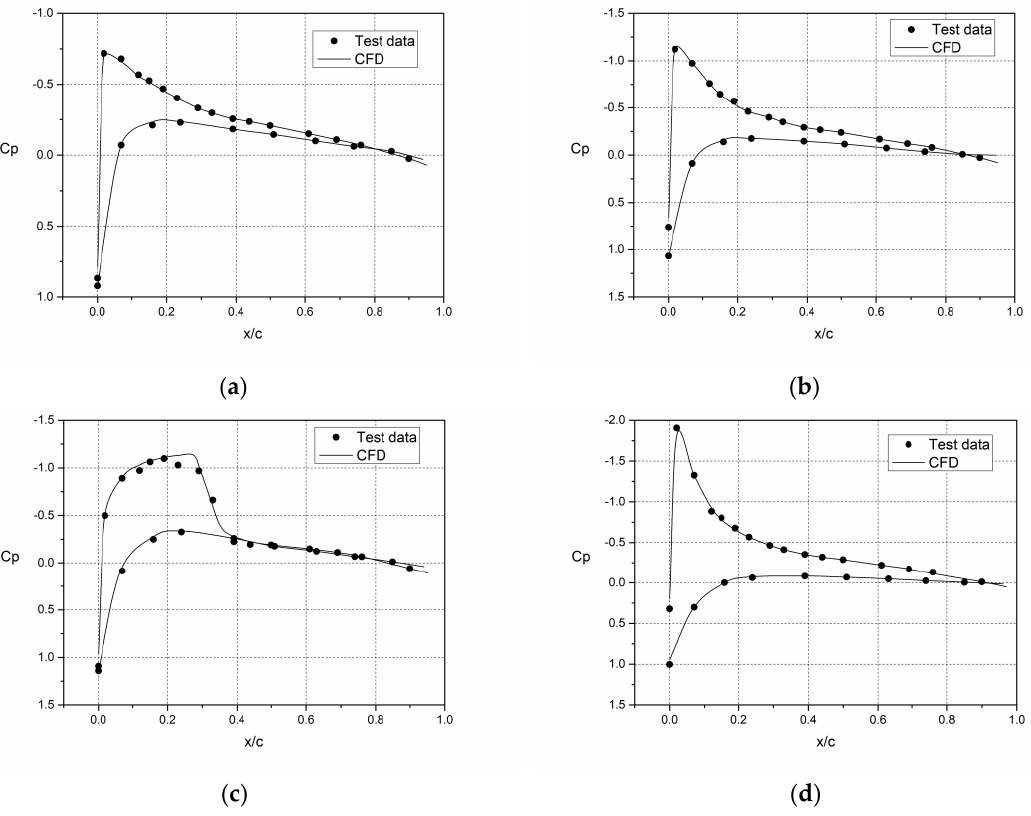
Figure 4. Vorticity contours of flow field in condition 3.